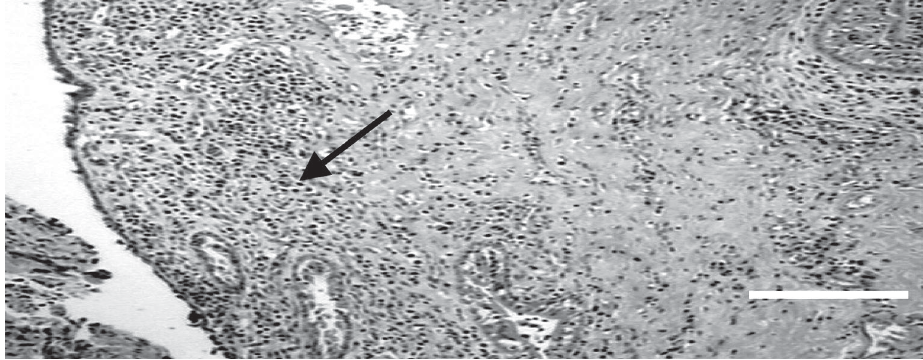
Figure 2. Transverse microscopic section through the urethra repaired with a bovine pericardium graft, showing inflammatory cells (arrow) in the mucosa and epithelial growth (HE, Bar = 100